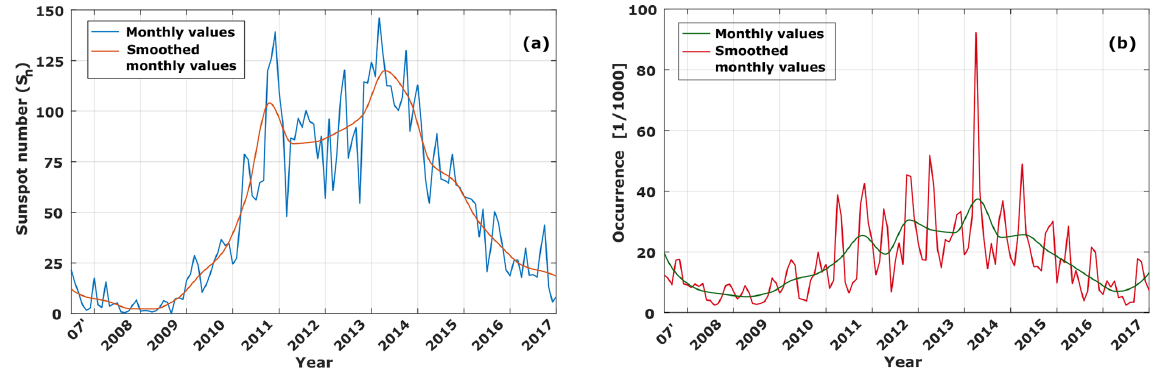
Figure 8. Comparison plot of (a) sunspot cycle and (b) occurrence trend of equatorial plasma bubbles from mid-2007 to 2017, with monthly values and smoothed monthly values using a low-pass